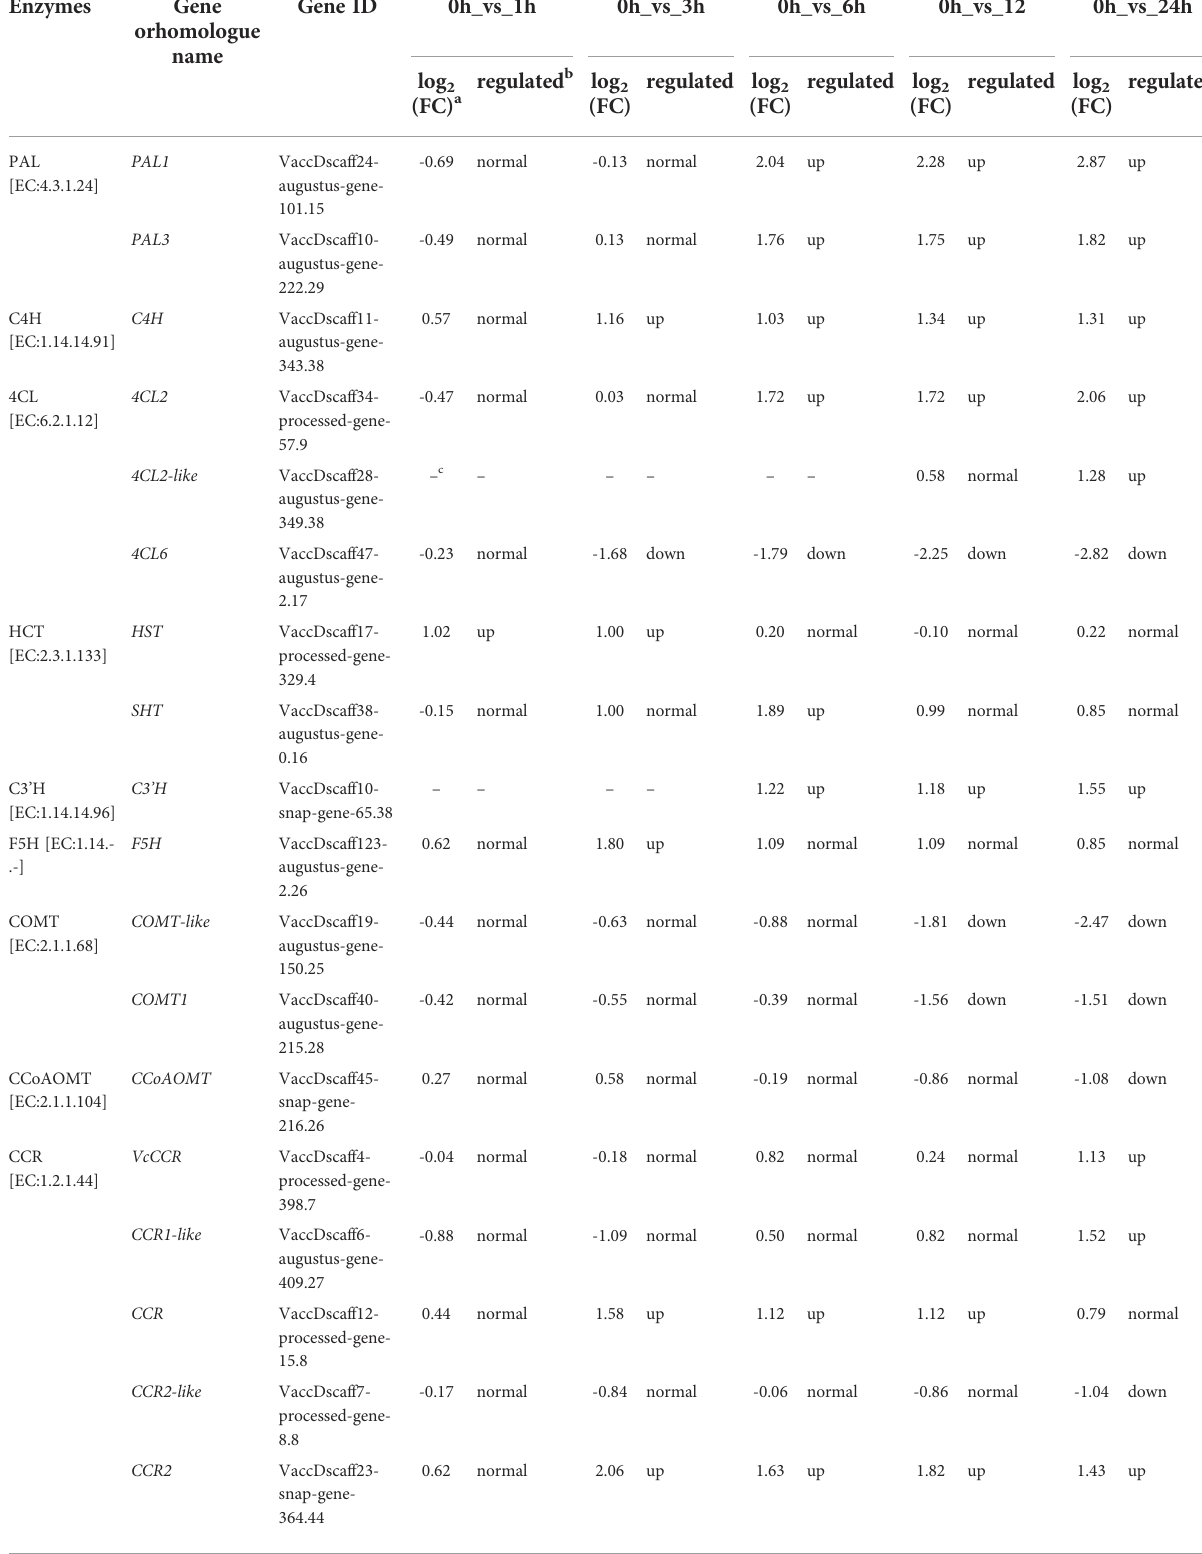
TABLE 2 The regulation of DEGs involved in fl avonoid biosynthesis under UV-B radiation.